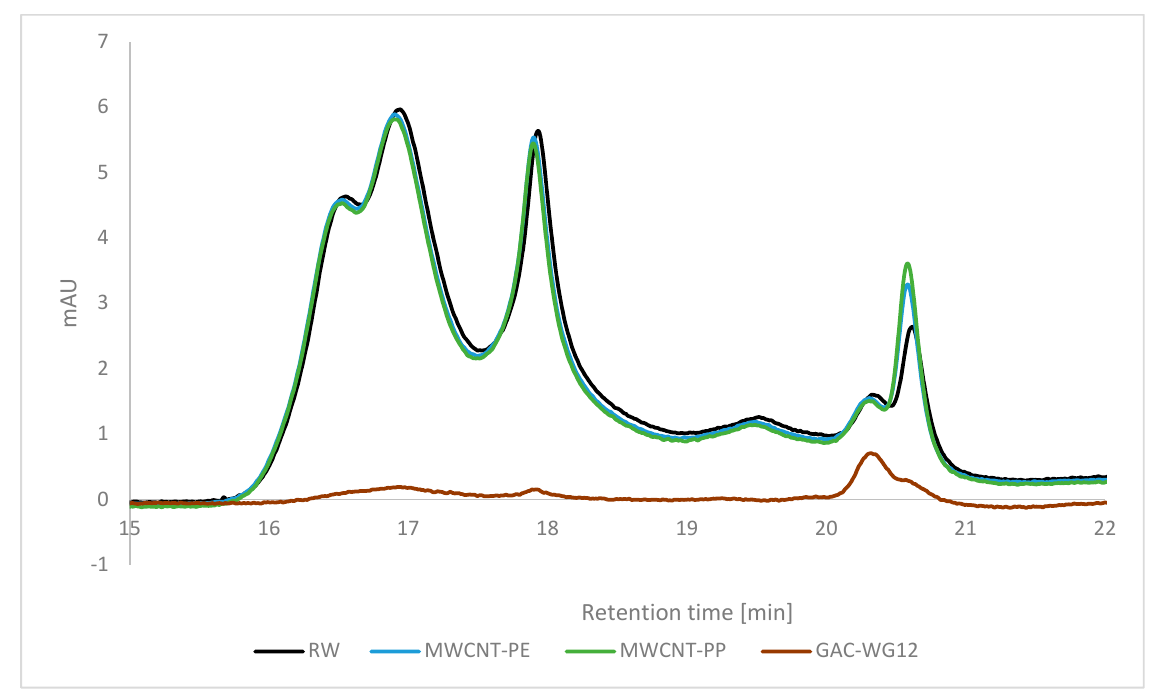
Figure 7. Chromatograph of the molecular size distribution in raw and post-adsorption water. Among the substances removed on the adsorbents containing carbon nanotubes, molecules in the range of 0.5–0.7 kDa dominated (Figure 8).